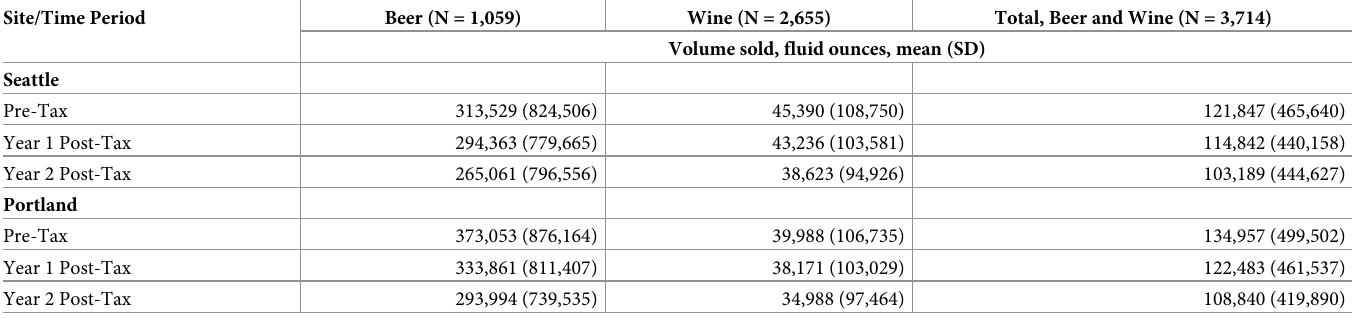
Table 1. Mean alcoholic beverage volume sold in Seattle, Washington, and Portland, Oregon, before and after implementation of the Seattle Sweetened Beverage Tax, 2017–2019 a . Site/Time Period